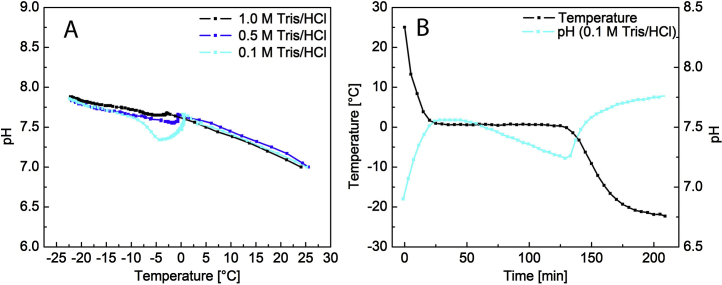
pH shifts during freezing of pure Tris/HCl buffer measured at three different concentrations (initial pH value was pH 7.0).